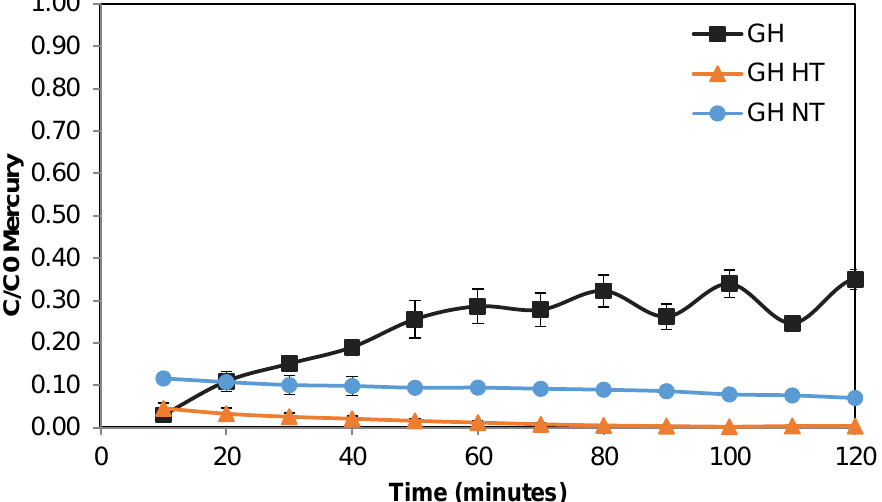
Figure 13. Elemental mercury removal for untreated and treated graphite.